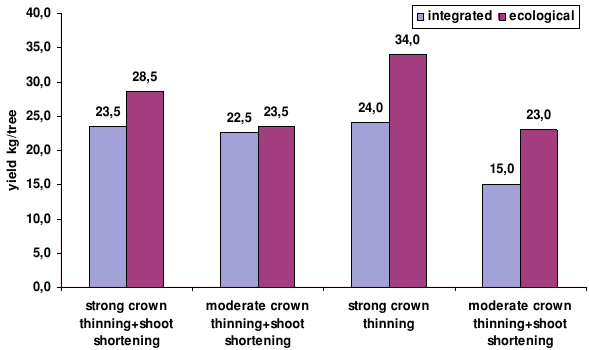
Figure 5. The effect of pruning methods on the specific quantity of fruiting structures developed during the season of pruning in ‘Idared’ apple trees grafted on M 26 root in ecological and integrated growing systems (Debrecen-Pallag